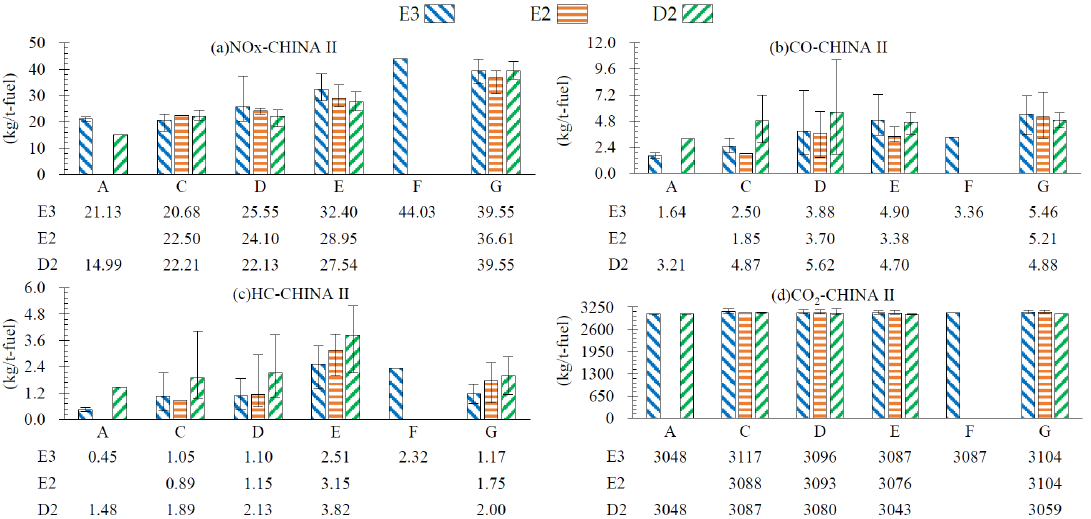
Figure 2. Fuel-based emission factors for different single-cylinder displacements under the CHINA I standard. ( a ) NOx-specific emissions in the E3, E2, and D2 cycles; ( b ) CO-specific emissions in the E3, E2, and D2 cycles; ( c ) HC-specific emissions in the E3, E2, and D2 cycles; ( d ) CO 2 -specific emis- sions in the E3, E2, and D2 cycles.